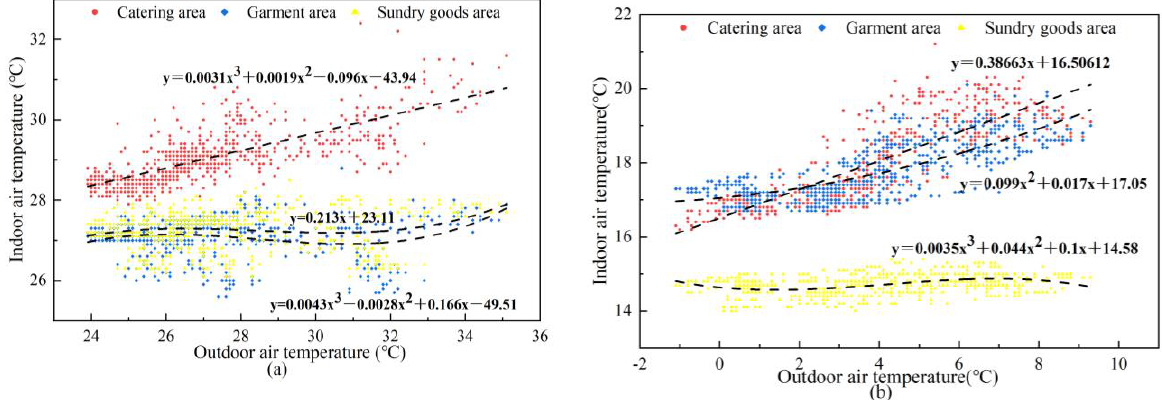
Figure 4. Correlation analysis between indoor and outdoor air temperatures in summer ( a ), and winter ( b ).